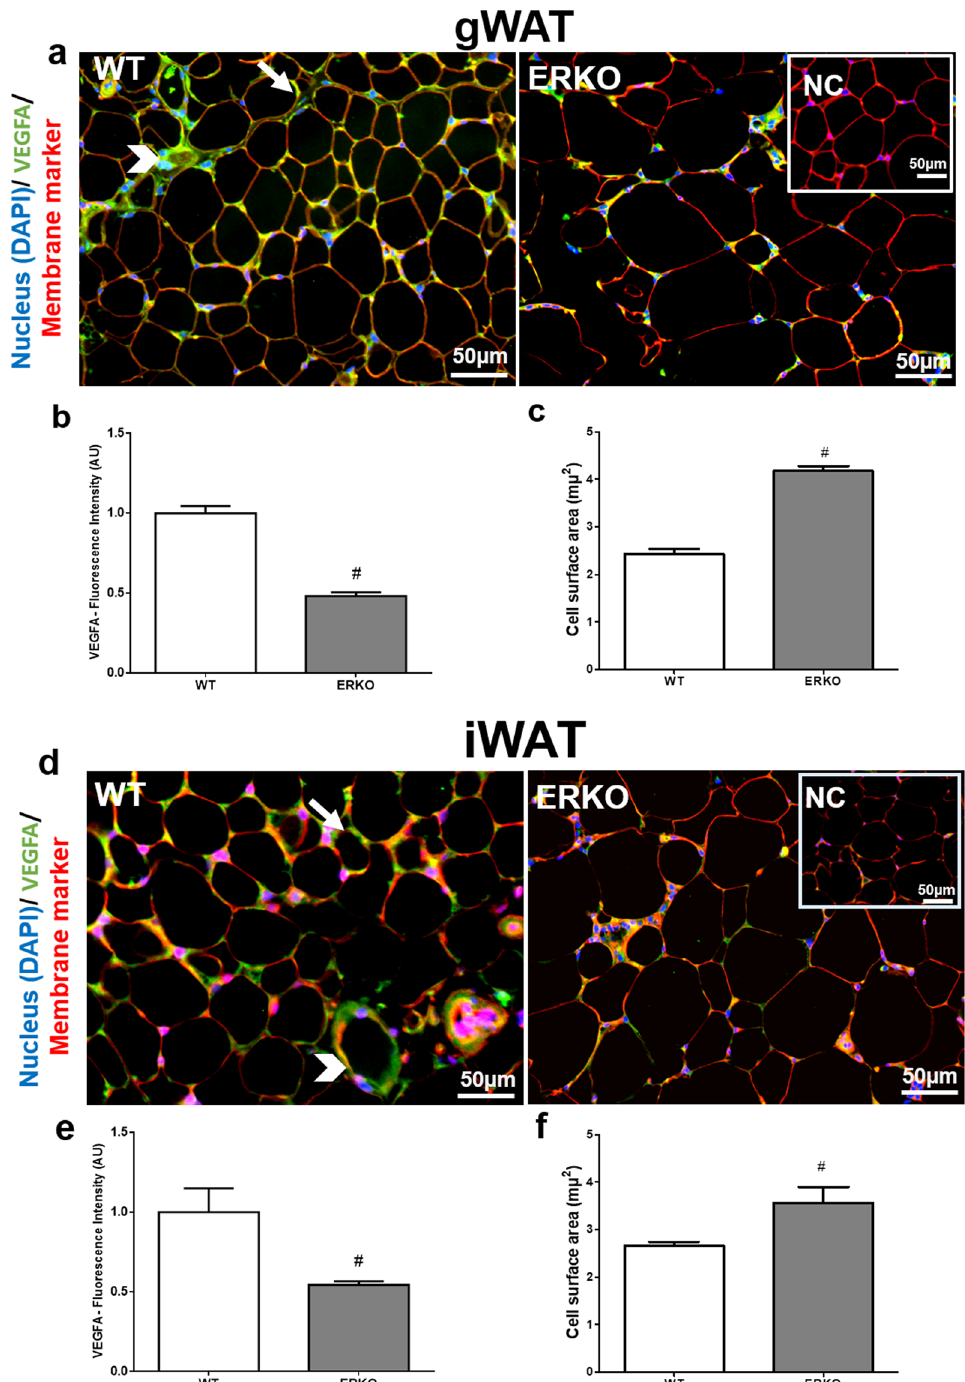
Figure 8. VEGFA protein expression in gonadal (gWAT) and inguinal (iWAT) adipose tissue from WT and ERKO female mice. Immunofluorescence staining of VEGFA in gWAT ( a ) and iWAT ( d ). Nucleus in blue (DAPI), VEGFA in green, membrane marker in red, and composite in yellow/orange; arrows indicate VEGFA expression in adipocytes and arrowheads in vessels; scale 50 μ m; Fluorescence intensity quantification in gWAT ( b ) iWAT ( e ). Adipocyte size (surface area- μ m 2 ) in gWAT ( c ) iWAT ( f ). Data on the graphs are means ± SEM of 4–7 samples, # p < 0.05 vs WT. NC = negative